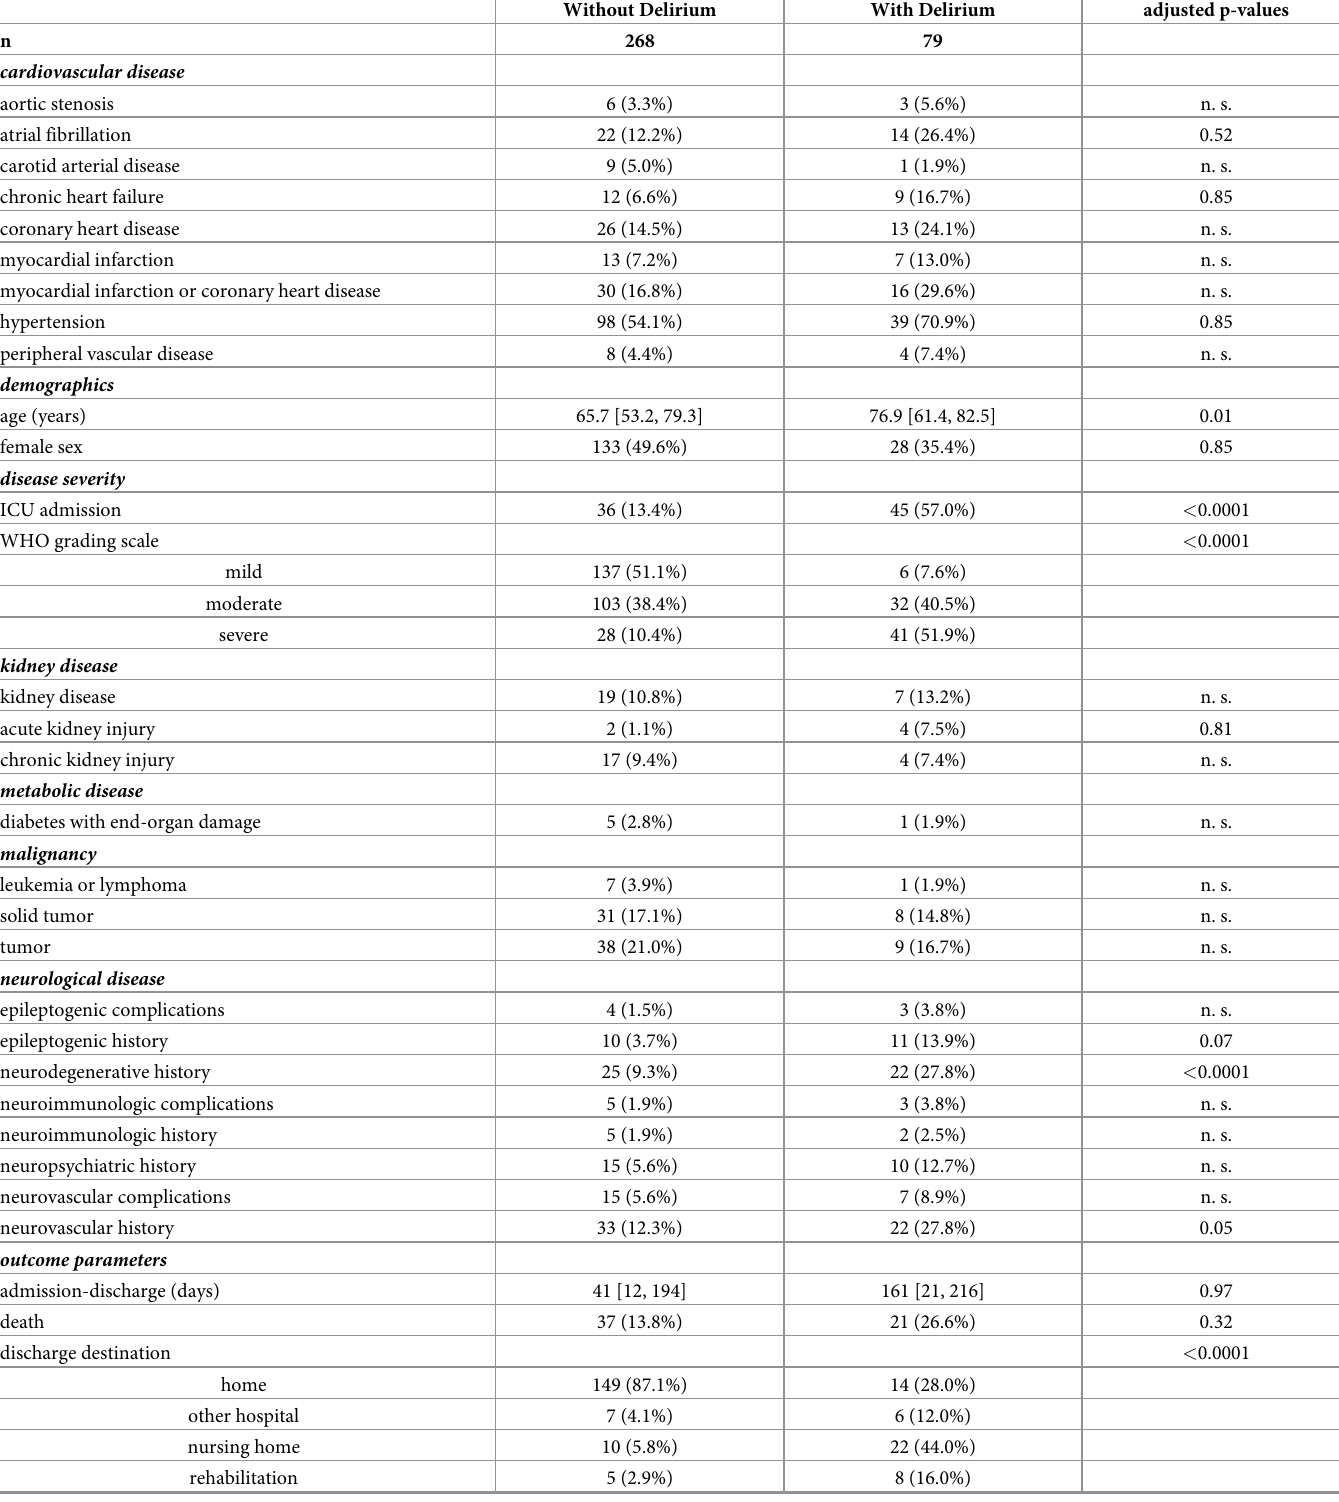
Table 2. Demographic, clinical and laboratory patient characteristics stratified by the occurrence of